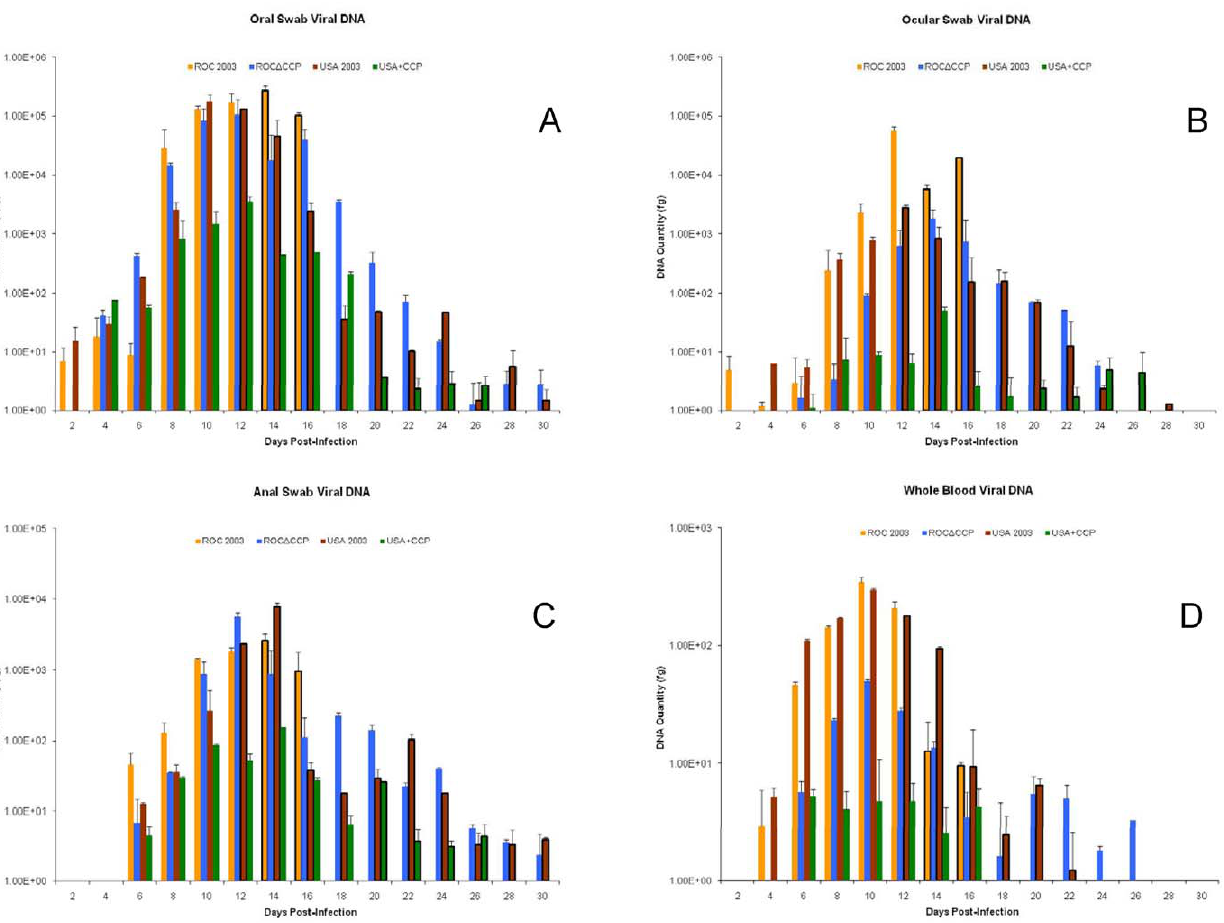
Figure 7. Monkeypox virus DNA loads. Mean viral DNA by real-time PCR for the oral (A), ocular (B), anal (C) and blood (D) samples collected from each animal in a challenge group. Dark bar borders indicate n , 4 for the mean generated on that day. The mean viral DNA for each infection group was graphed with standard deviations. Group comparisons within sampling days were not significantly different (p . 0.05).